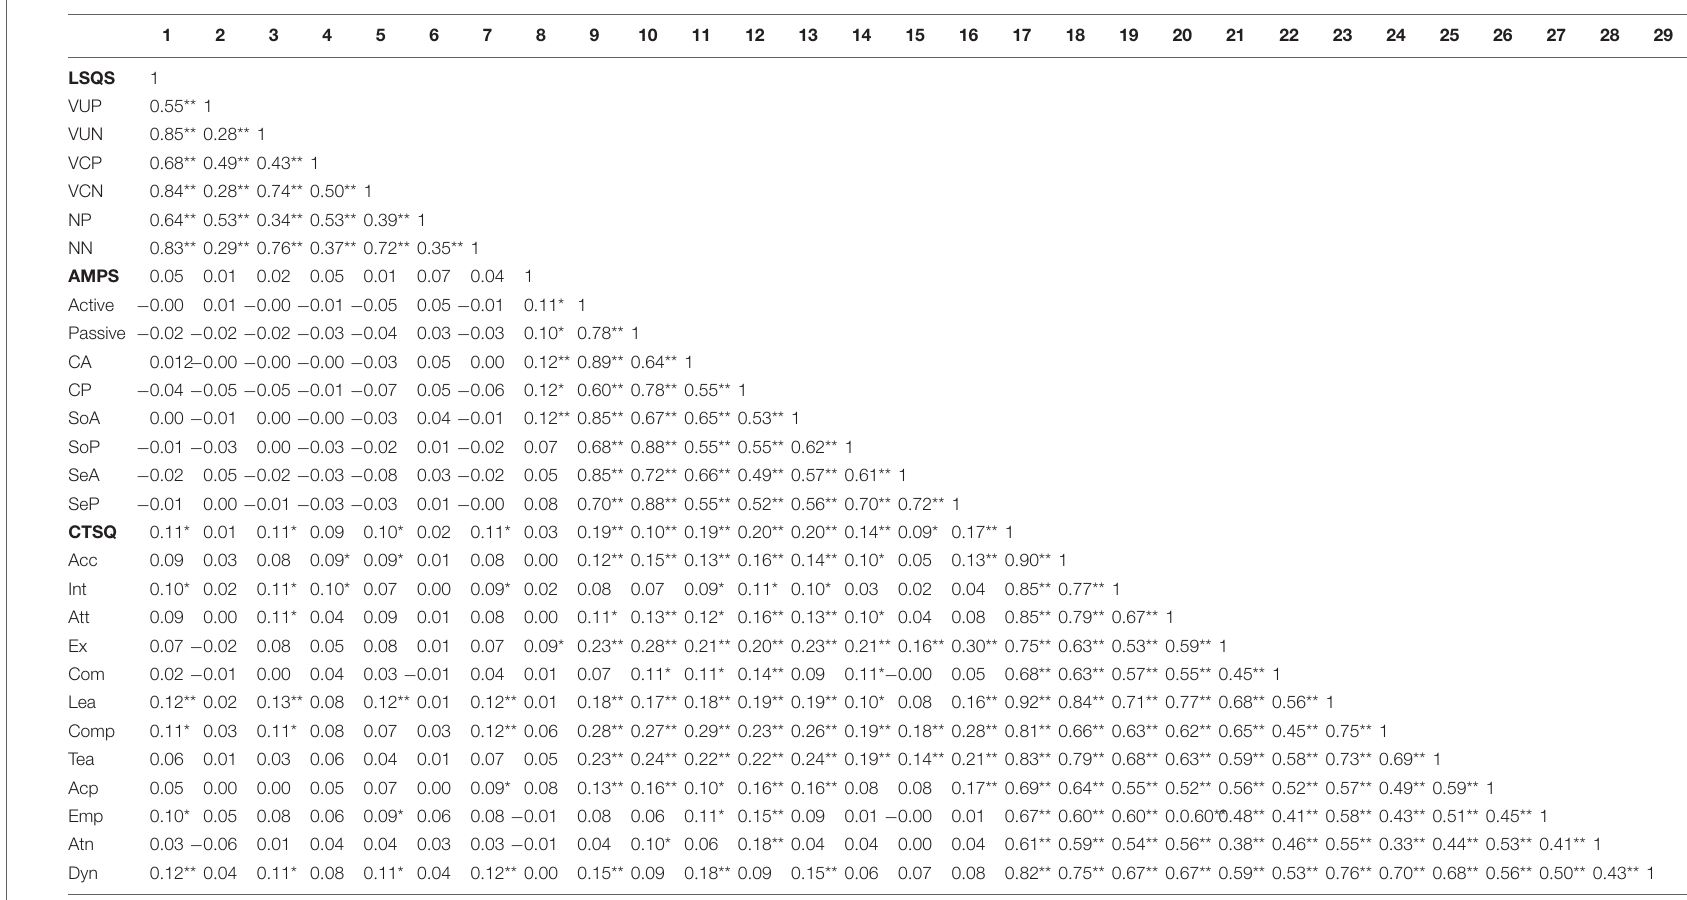
TABLE 2 | Correlational Analyses for the